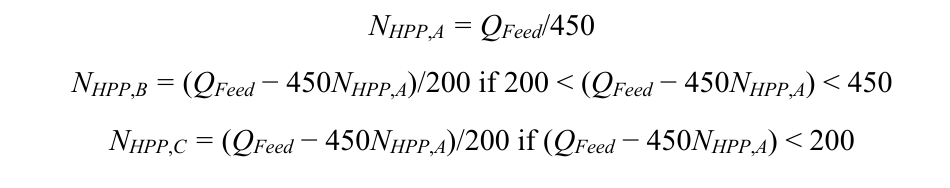
Table A1. Properties of seawater reverse osmosis membrane (Nitto